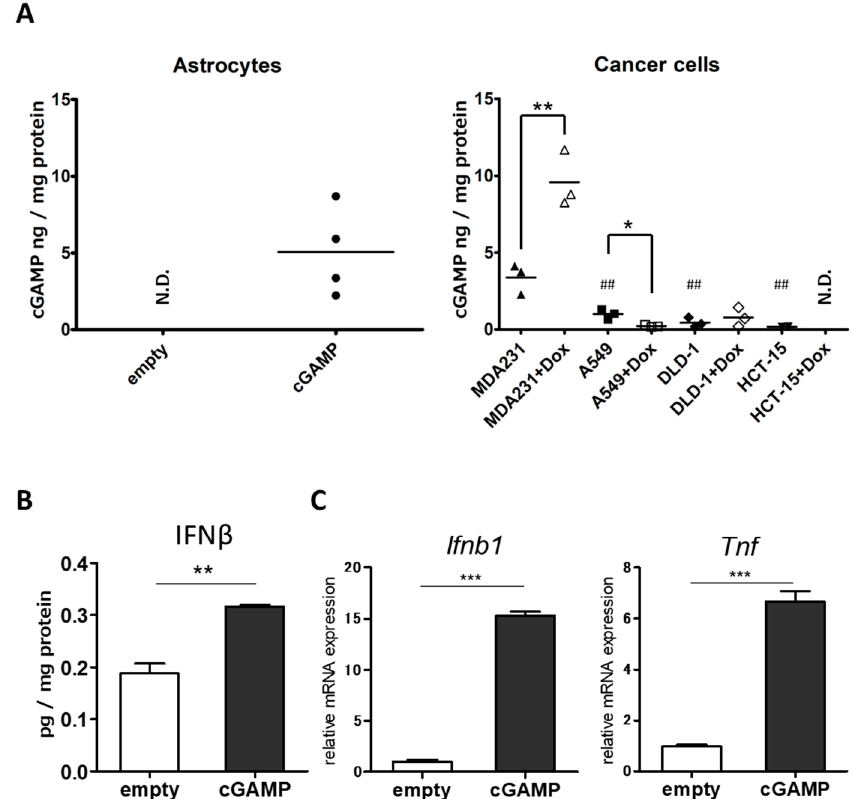
Figure 1. Activation of downstream STING in astrocytes by cGAMP uptake. ( A ) The amount of intracellular cGAMP in astrocytes 6 h after the addition of ssPalm (left panel) and cancer cells treated with doxorubicin for 24 h (right panel) was measured using ELISA (empty, n = 2; cGAMP, n = 4; cancer cells, n = 3). Statistical analyses were performed using Student’s t -test for comparison between the control and Dox treatment groups for each cancer cell (* p < 0.05, ** p < 0.01) or Dunnett’s test for comparing A549, DLD-1, and HCT-15 with MDA231 ( ## p < 0.01). ( B ) The amount of IFN β in the supernatant of astrocyte culture 6 h after the addition of ssPalm-cGAMP (n = 3, ** p < 0.01, Student’s t -test). ( C ) mRNA levels of Ifnb1 and Tnf in astrocytes 6 h after the addition of ssPalm-cGAMP (n = 3, ** p < 0.01, *** p < 0.001, Student’s t ‐ test).